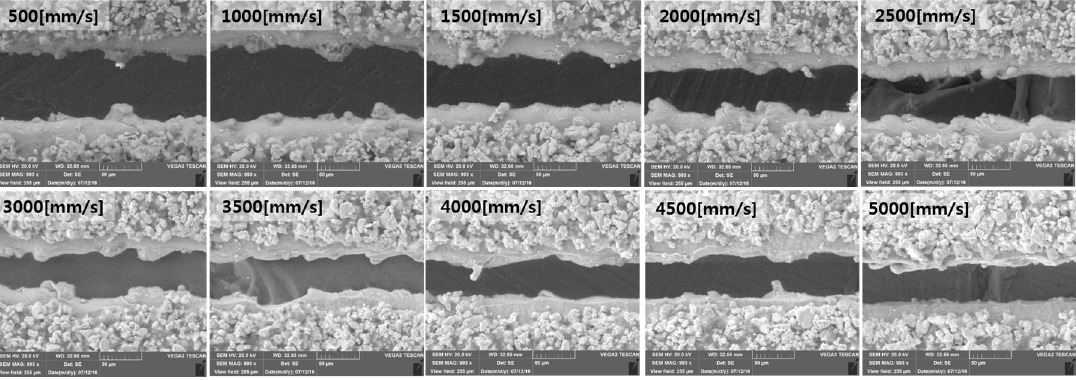
Figure 9. Scanning Electron Microscope (SEM) image with a laser power of 250 W. Figure 7. Clearance width by laser power. Appl. Sci. 2017 , 7 , 914